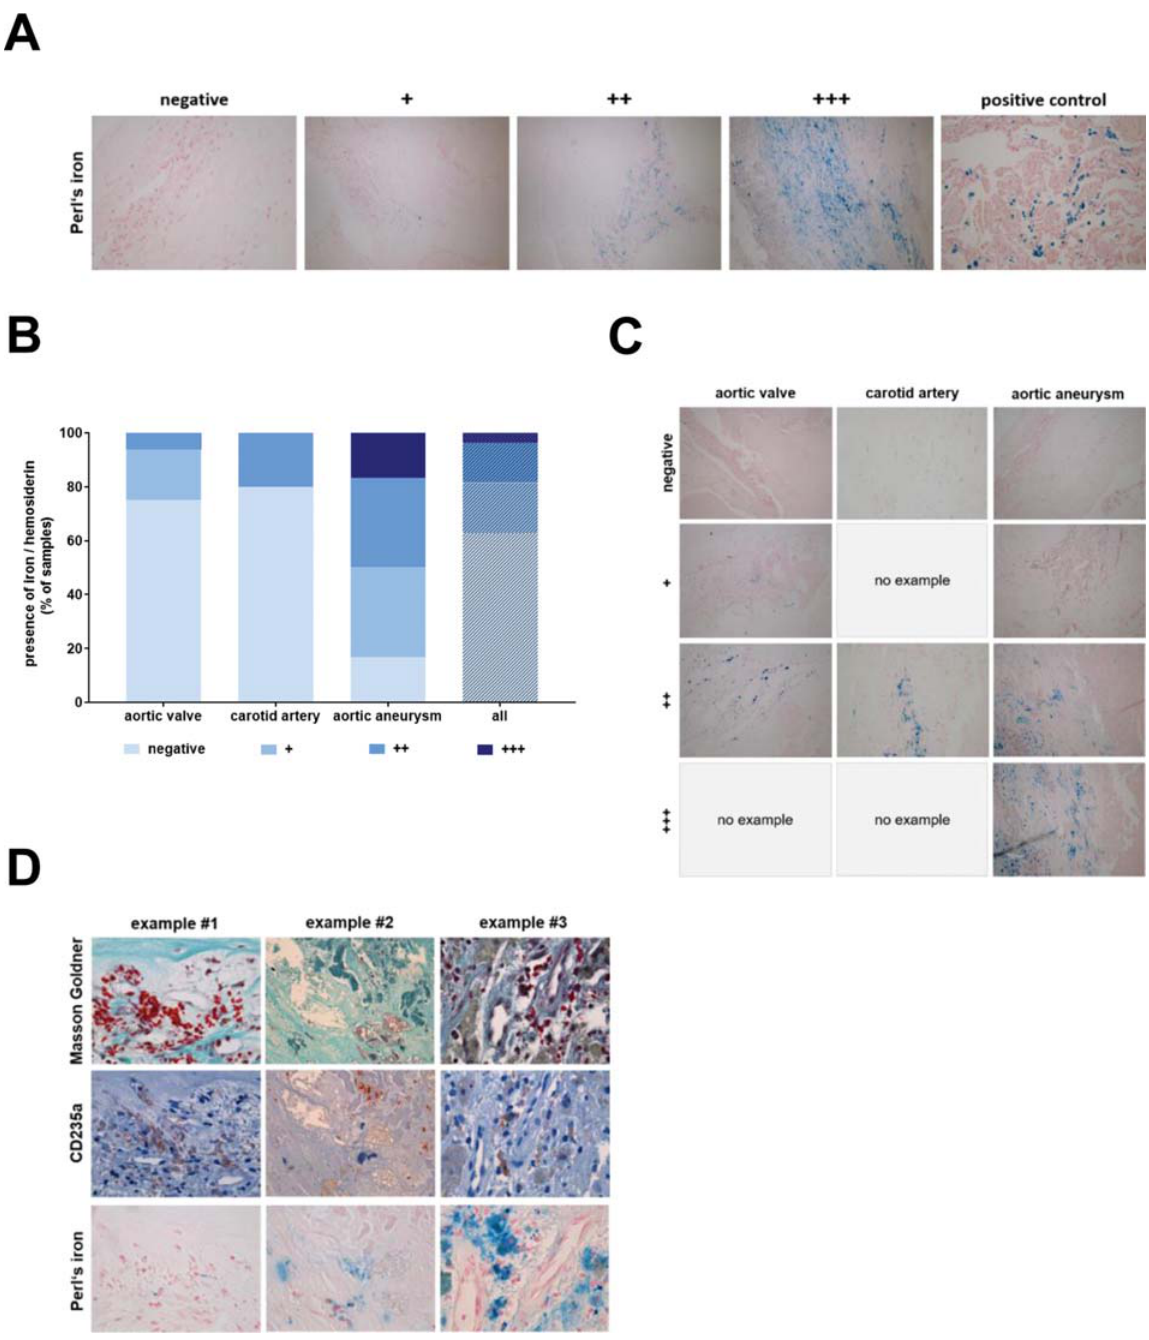
Fig. 4 Detection of free iron and hemosiderin in human vascular lesions. ( A ) Examples of the extent of iron/hemosiderin deposition and its grading in absent (negative), low ( þ ), middle ( þþ ) and high ( þþþ ); 200-fold magni fi cation. Findingsinmurinelung (positive control) are shown to demonstrate typical positive signals. ( B ) Results of the quantitative analysis. Results are expressed as percentage (%) of the total number of tissue samples. ( C ) Representative fi ndings of iron/hemosiderin depositions in samples of human aortic valve, carotid artery plaque and aortic aneurysm; 200-fold magni fi cation. ( D ) Examples showing the colocalization of erythrocytes (following Masson – Goldner trichrome or CD235a staining) with iron/hemosiderin following Perl ’ s iron staining. 1,000-fold magni fi